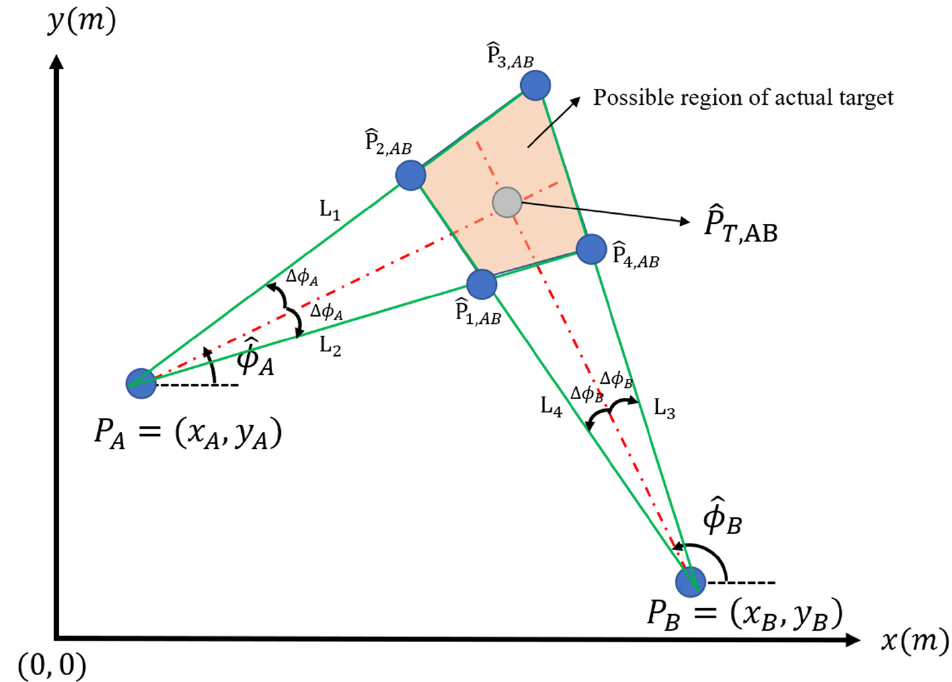
Figure 2. Possible region of the actual